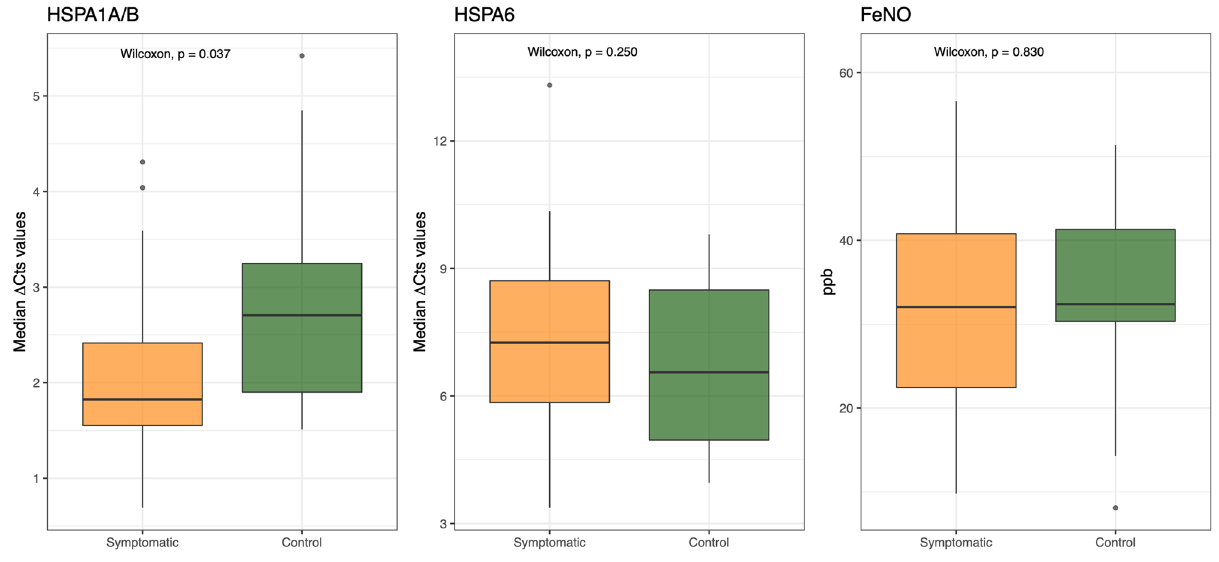
Figure 1. Boxplot of median ∆Ct values for HSPA1A/B and HSPA6 transcripts and ppb values for FeNO in the symptomatic AR patients (orange) and control group (green). Higher ∆Ct values stand for lower mRNA expression.